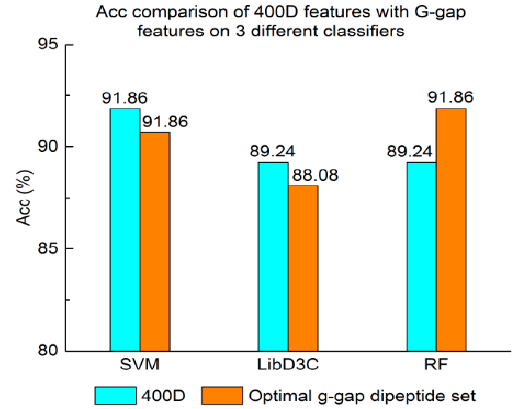
Figure 2. Overall accuracy comparison of 400D features with G-gap features on three different classifiers. RF: random forest.